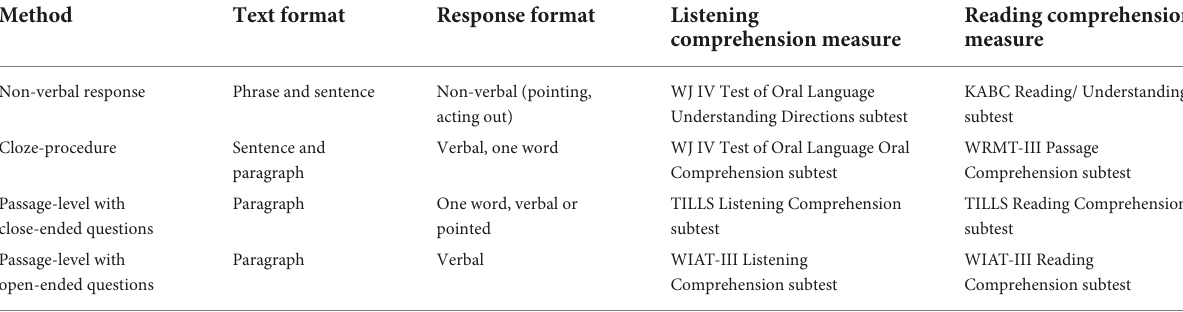
TABLE 4 Methods of measuring listening comprehension and reading